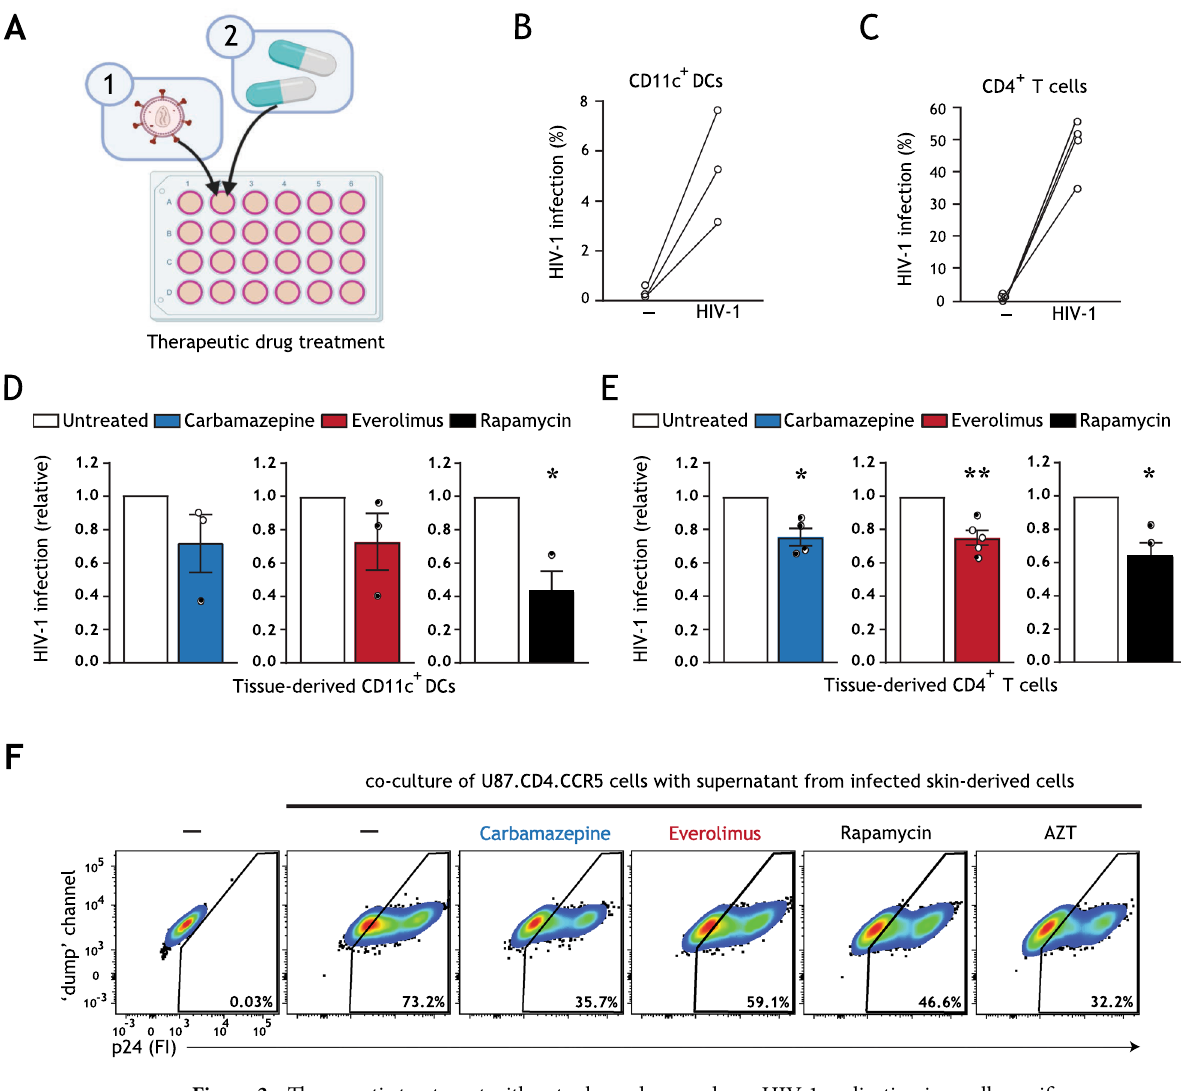
Figure 3. Therapeutic treatment with autophagy drugs reduces HIV-1 replication in a cell-specific manner. ( A ) Brief schematic representation of HIV-1 tissue infection model for drug screening, an extended graphical representation of the therapeutic treatment model is available in Figure S3C, Supplementary Information. Biopsies including epithelium and subepithelium were taken from human skin tissue, infected with HIV-1 NL4.3BaL for 15 h, and subsequently treated with autophagy drugs. HIV-1 infection of different cell types and subsets was quantified using multiparameter flow cytometry. A detailed gating strategy can be found in Supplementary Information Figure S4. ( B – E ) Human tissue biopsies were therapeutically treated with carbamazepine (100 μM), everolimus (5 nM), or rapamycin (100 nM), or left untreated. HIV-1 infection of emigrated CD11c + DCs was determined as the percentage of CD3 − CD11c + p24 + cells ( B , D ), and HIV-1 infection of emigrated CD4 + T cells as the percentage of CD3 + CD11c − CD14 − CD1a − CD8 − p24 + cells ( C , E ),